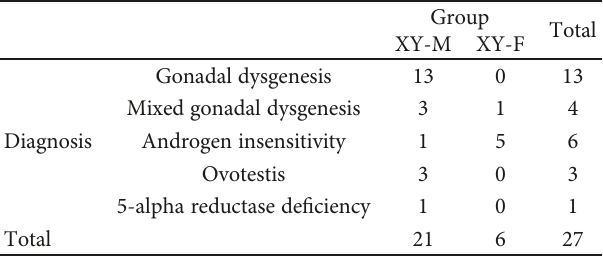
Table 3: Chart showing the grouping of patients and the distribution of diagnosis.